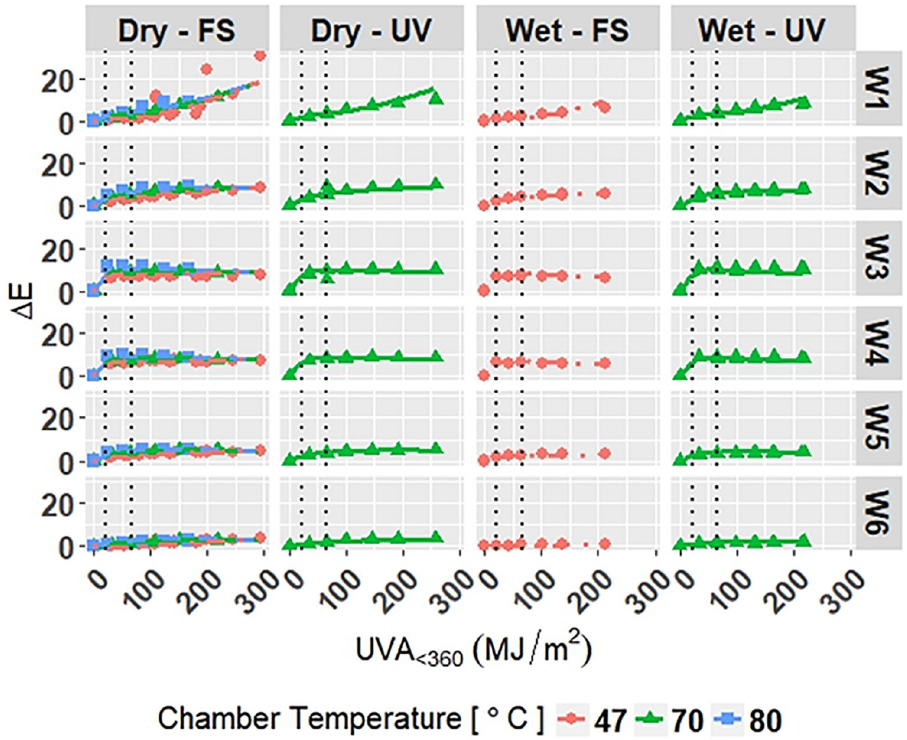
Fig 9. The change in Δ E for white grades of PET under accelerated exposures with the model curves superimposed on the data. Points represent the measured data and solid and dashed lines represent the models. Vertical, dotted lines represent the location of natural spline knots.